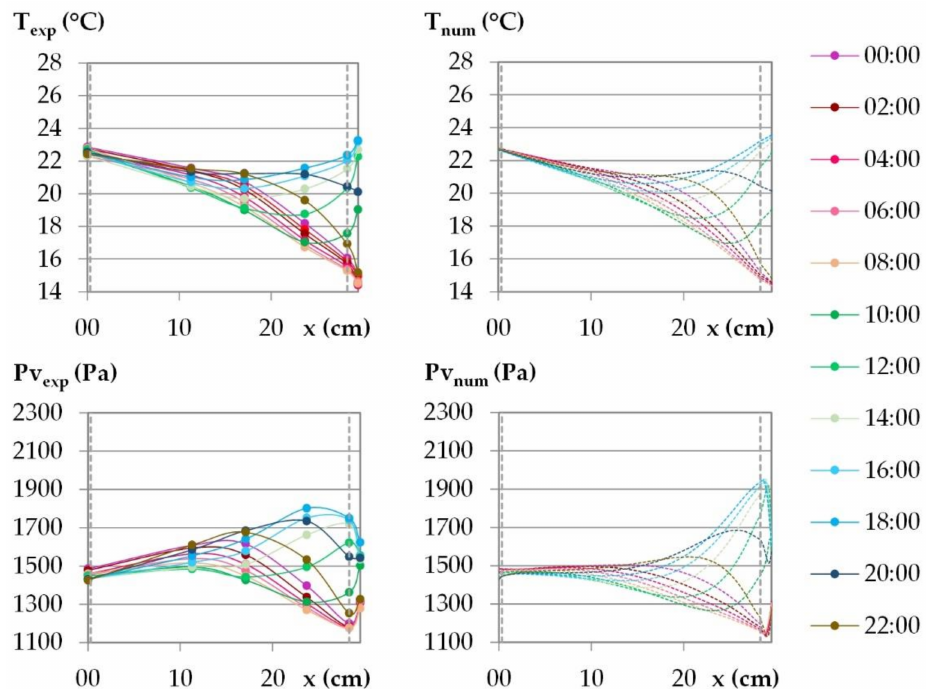
Figure 15. Temperature and vapor pressure profiles during the last day of the dynamic solicitation phase for the climate of Rennes. Points: experimental values; dotted lines: numerical values.